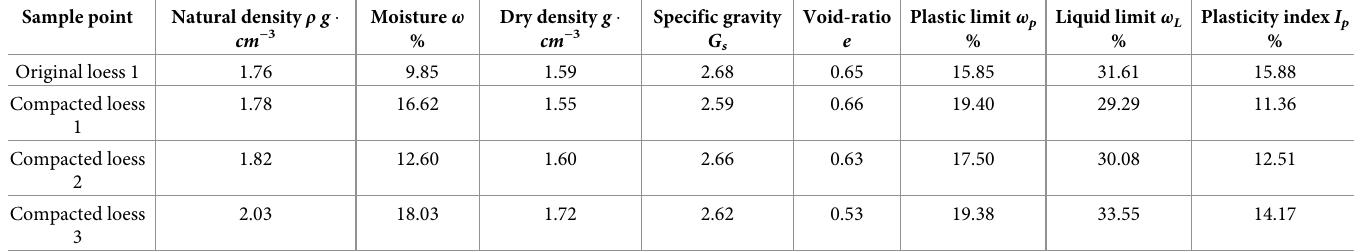
Table 3. Main physical properties of original loess and compacted loess at different